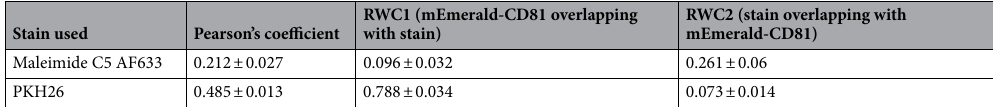
Table 3. A table summarising the quantitative colocalisation data of dual labelled mEmerald-CD81 EVs in recipient cells. Data was acquired from image analysis using the JACOPx ImageJ plugin. Data was generated by analysing 30 individual cells per condition. N = 3, (Biological) ±